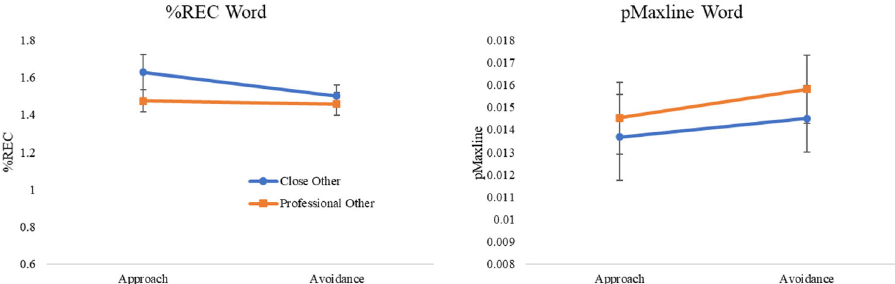
Fig. 6 Results of categorical recurrence quanti fi cation analysis for language analysis. Mean %REC ( left ) and pMaxline ( right ) of the verbal